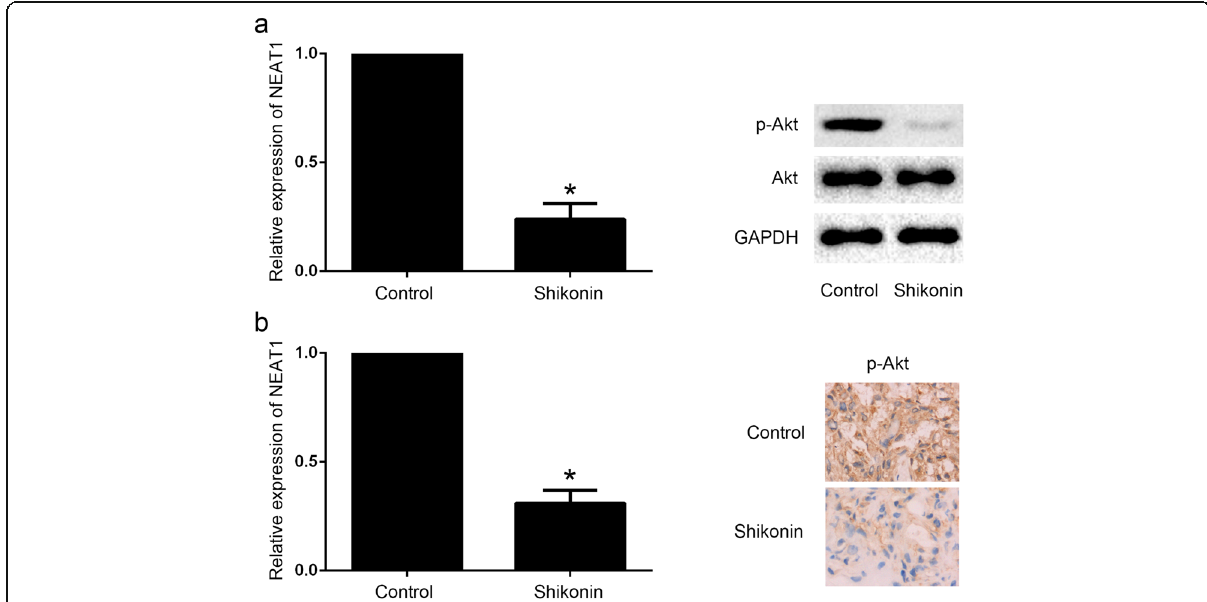
Fig. 3 Shikonin suppressed the level of NEAT1 and Akt signaling of paclitaxel-resistant NSCLC cell lines and xenograft tumors. a The level of NEAT1 expression was downregulated, and p-Akt expression was decreased after shikonin treatment compared to the control group in A549/PTX cells. b NEAT1 expression was downregulated, and p-Akt expression was decreased in the A549/PTX xenograft. *Statistically significant difference ( p <